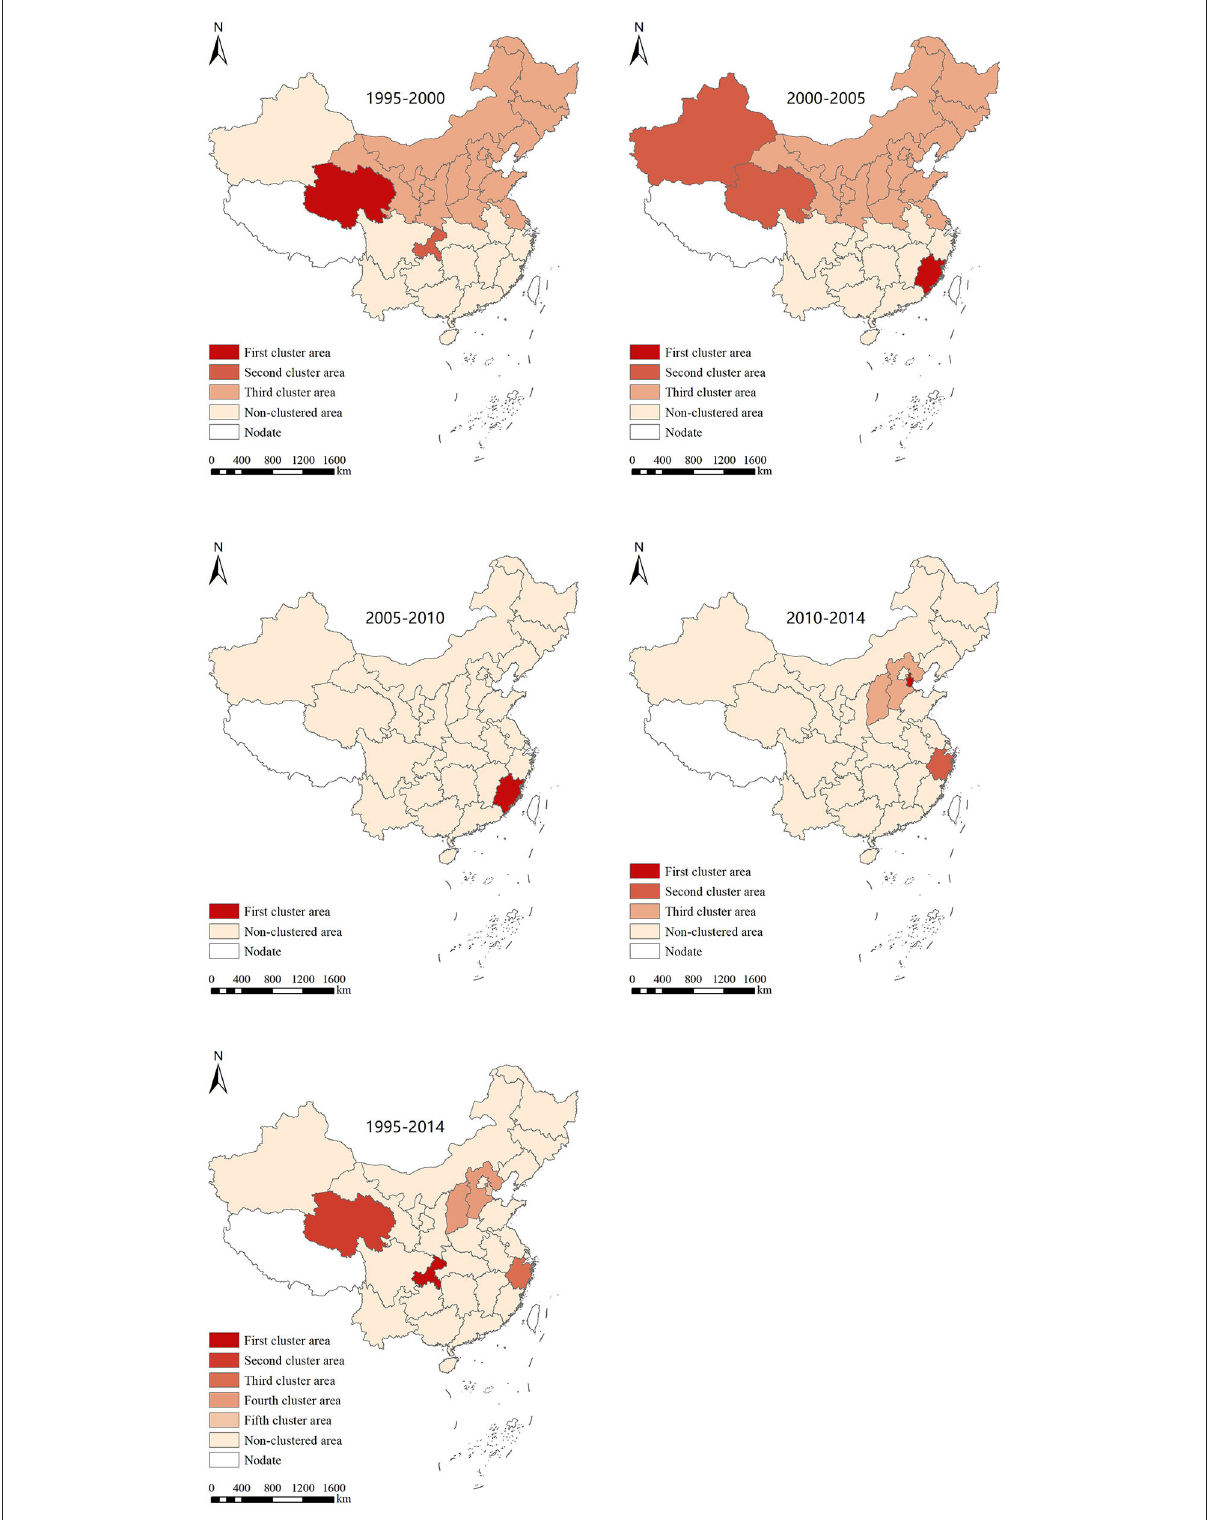
FIGURE4 Spatial and temporal scanning aggregation area for the prevalence of myopia in Chinese students from 1995 to